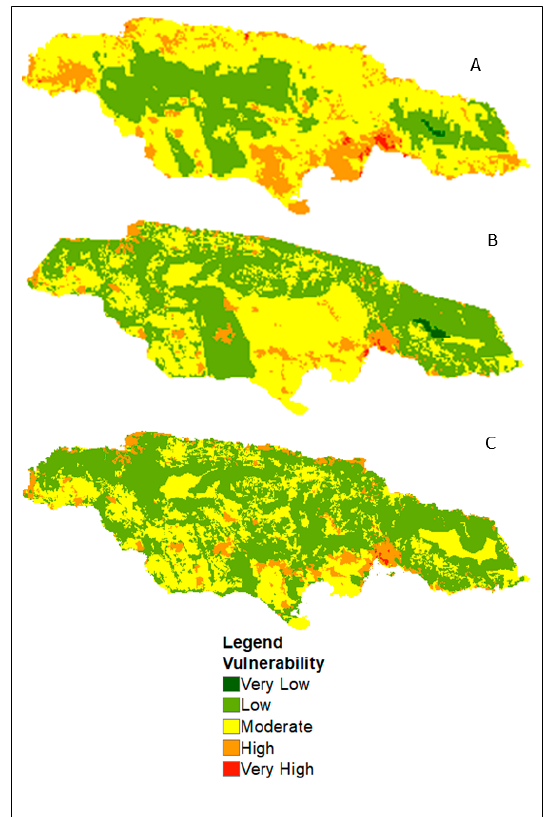
Figure 4. Dengue vulnerability with ( A ) WorldClim dataset ( B ) CHIRPS rainfall and LST, and ( C ) and climate change projection for 2030 for the month of October.